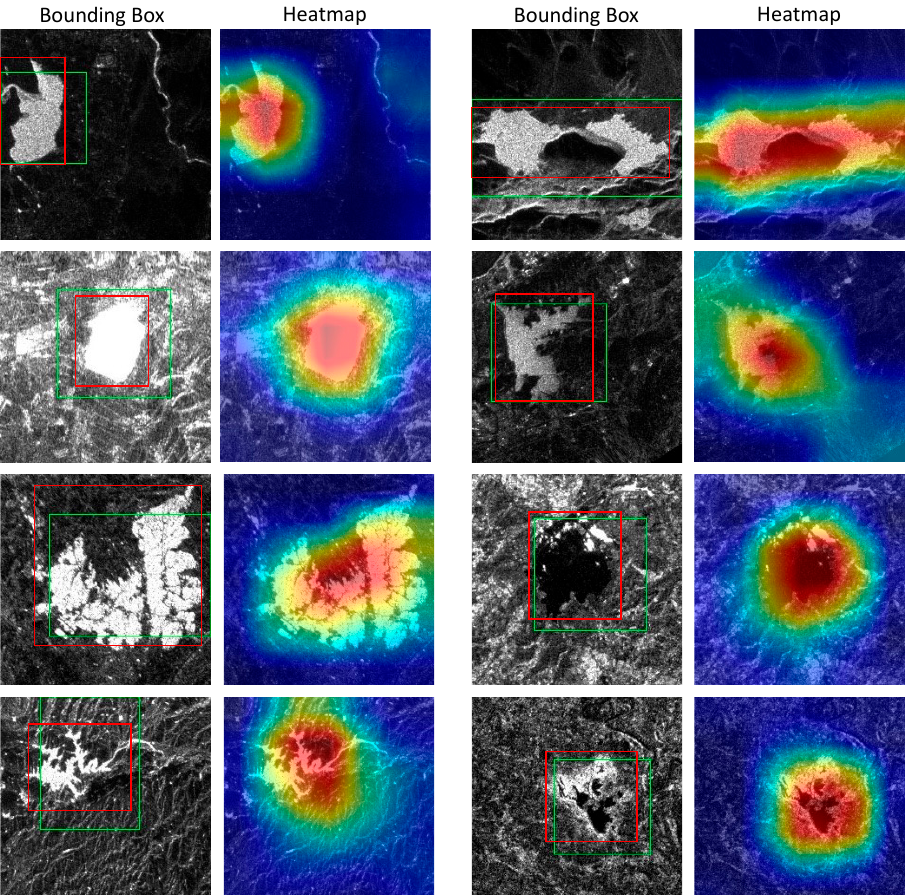
Figure 8. Qualitative cross-domain weakly supervised lake location results.